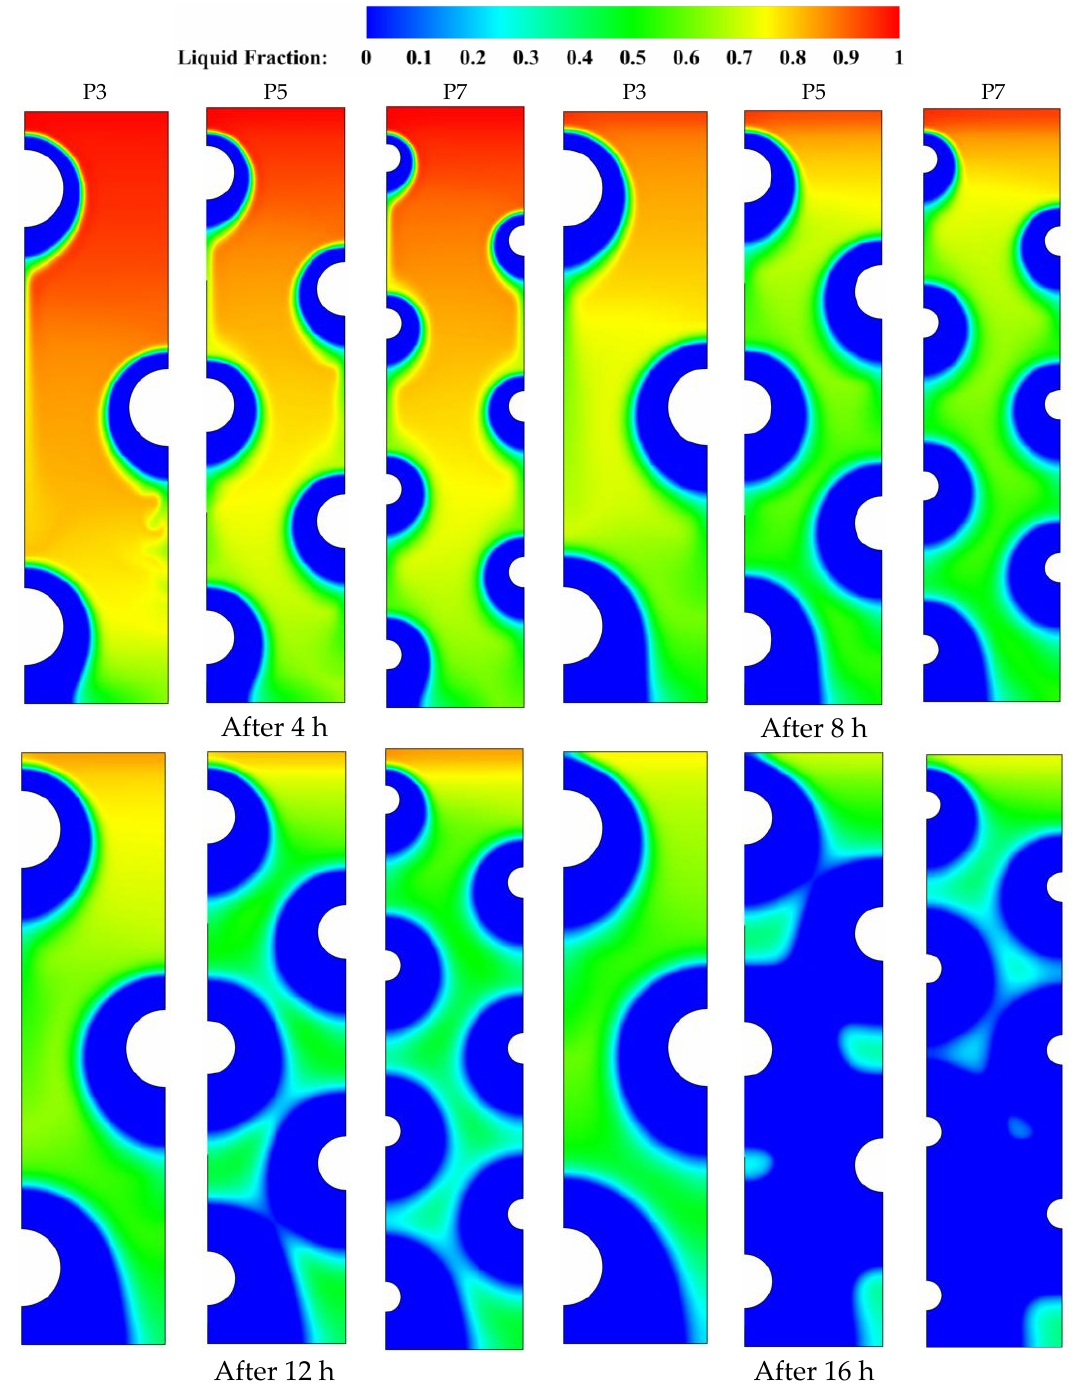
Figure 4. Contours of the PCM liquid-fraction progression for three different HTF-tube arrangements of P3, P5, and P7 over multiple solidification durations.